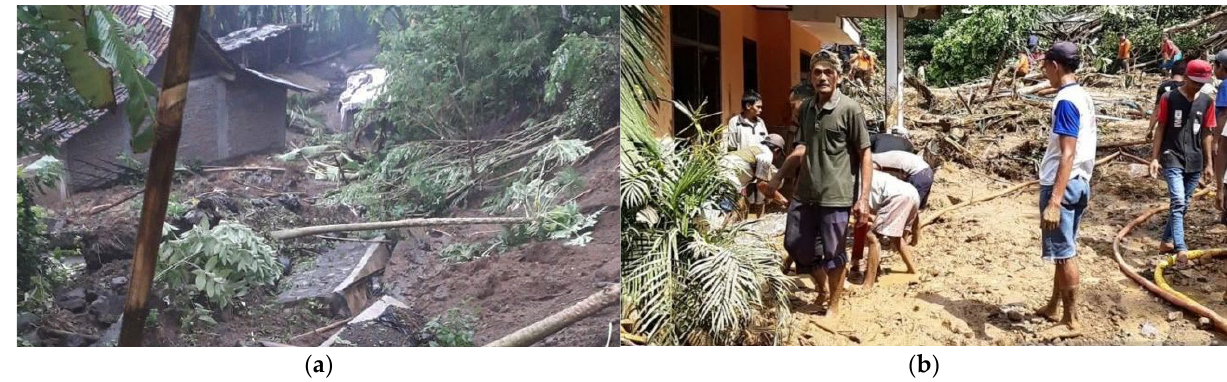
Figure 3. Landslide events triggered by rainfall in Java Island ( a ) at Purworejo District on 28 October